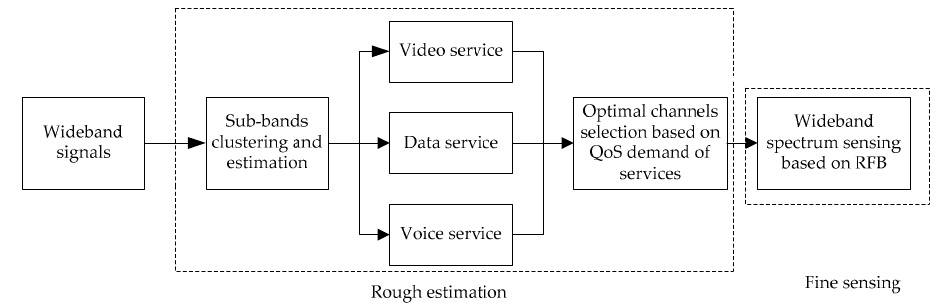
Figure 1. Rough estimation and fine sensing of wideband spectrum.